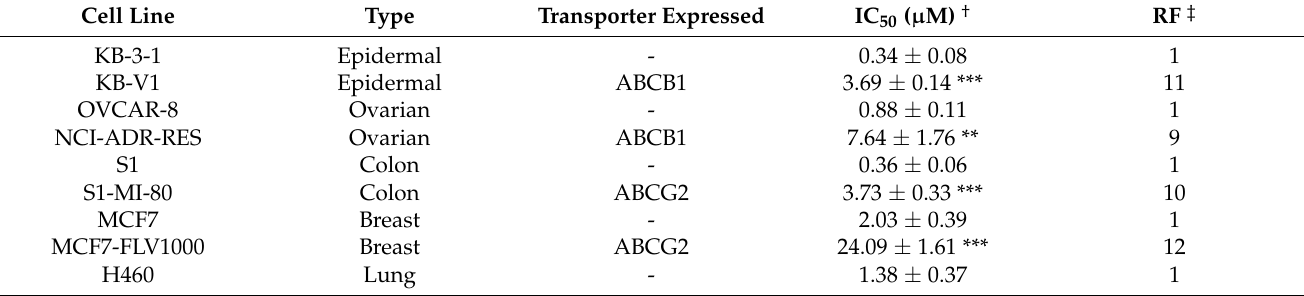
Table 1. Cytotoxicity of HS-173 in drug-sensitive cells and multidrug-resistant cells overexpressing either human ABCB1 or